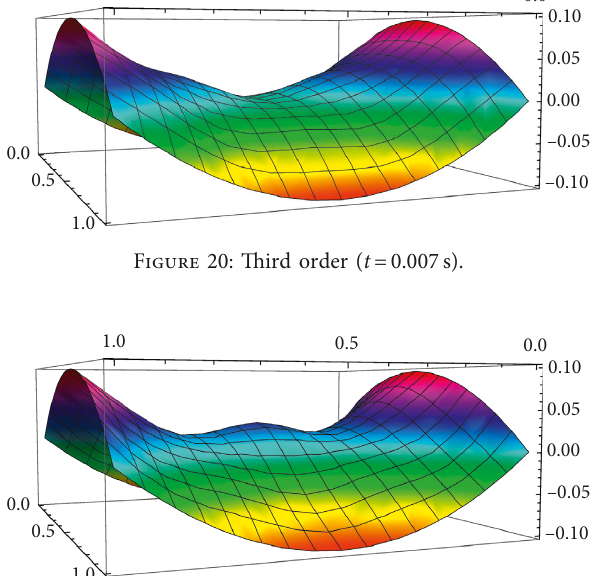
Figure 16: First order ( t � 0.007s).